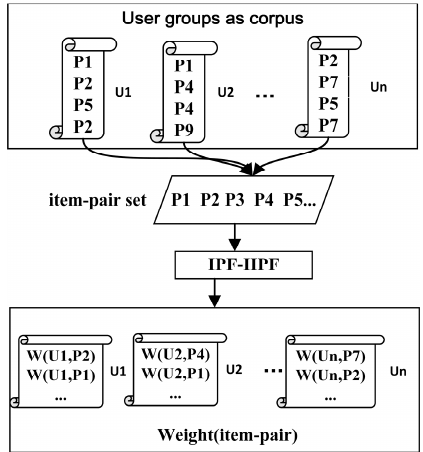
Figure 1. Overview of IPF—IIPF (Item-pair Frequency—Inverse item-pair Frequency).